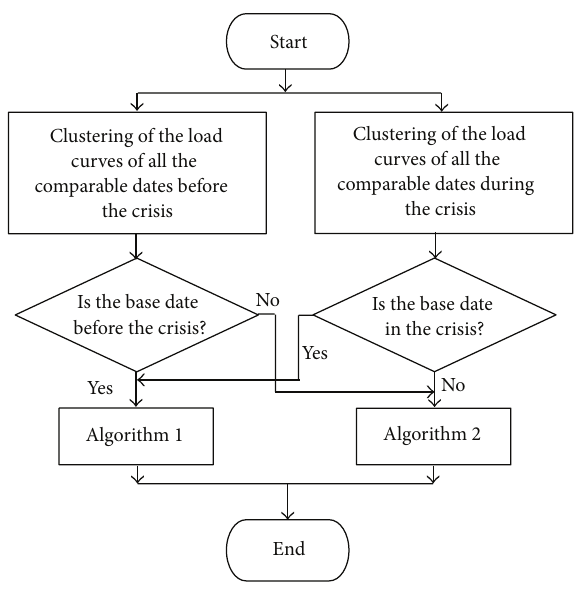
Figure 3: Eighth stage